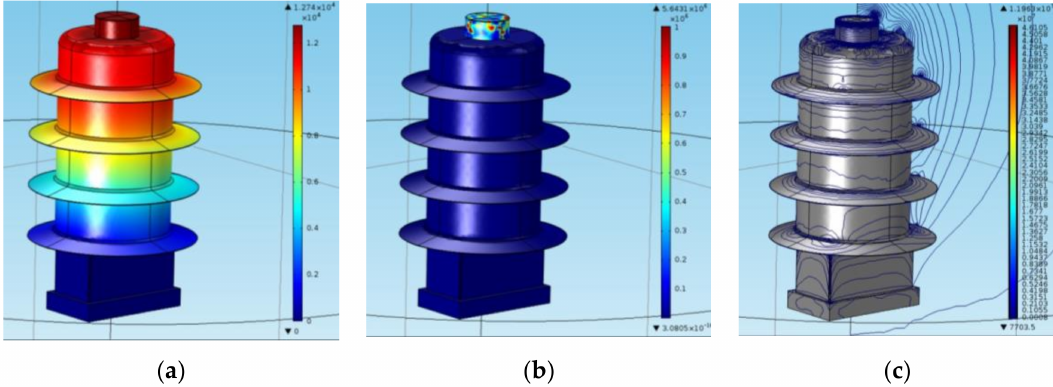
Figure 16. ( a ) Electric potential; ( b ) current density; ( c ) electric field distributions form the FEA